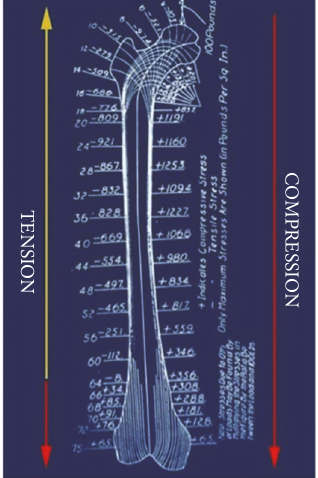
Figure 2: Koch’s “quantification” of forces within the femur [1]. According to the Koch Model, during unilateral stance, (1) most of the lateral cortex experiences tensile loading and (2) the distal 1/3 of the lateralcortex and entire medial cortexexperiences